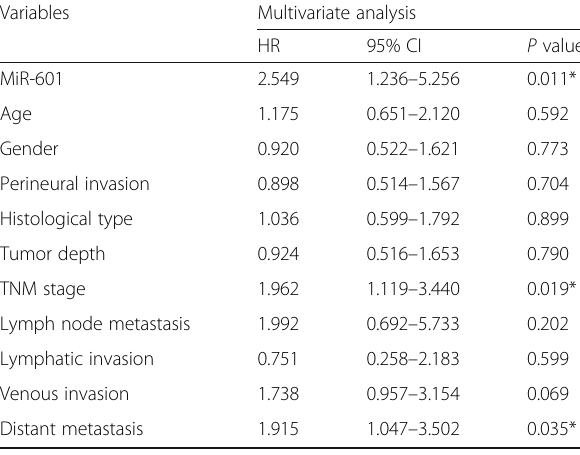
Table 2 Multivariate Cox regression analysis for miR-601